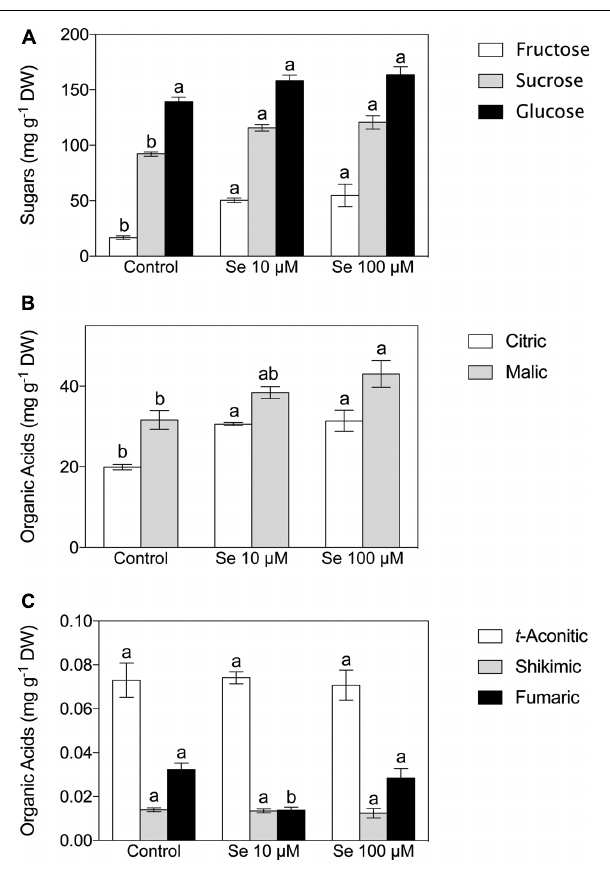
FIGURE 1 | Sugar (A) and Organic Acid (B,C) concentration of strawberry fruit grown in a full nutrient (control) or in a nutrient solution either supplied with 10 µ M Se (Se 10 µ M) or 100 µ M (Se 100 µ M). Data are reported as means ± SE, n = 3. The statistical significance was tested by means of ANOVA with Tukey post-test. Different letters indicate statistically different values ( P ≤ 0.05).